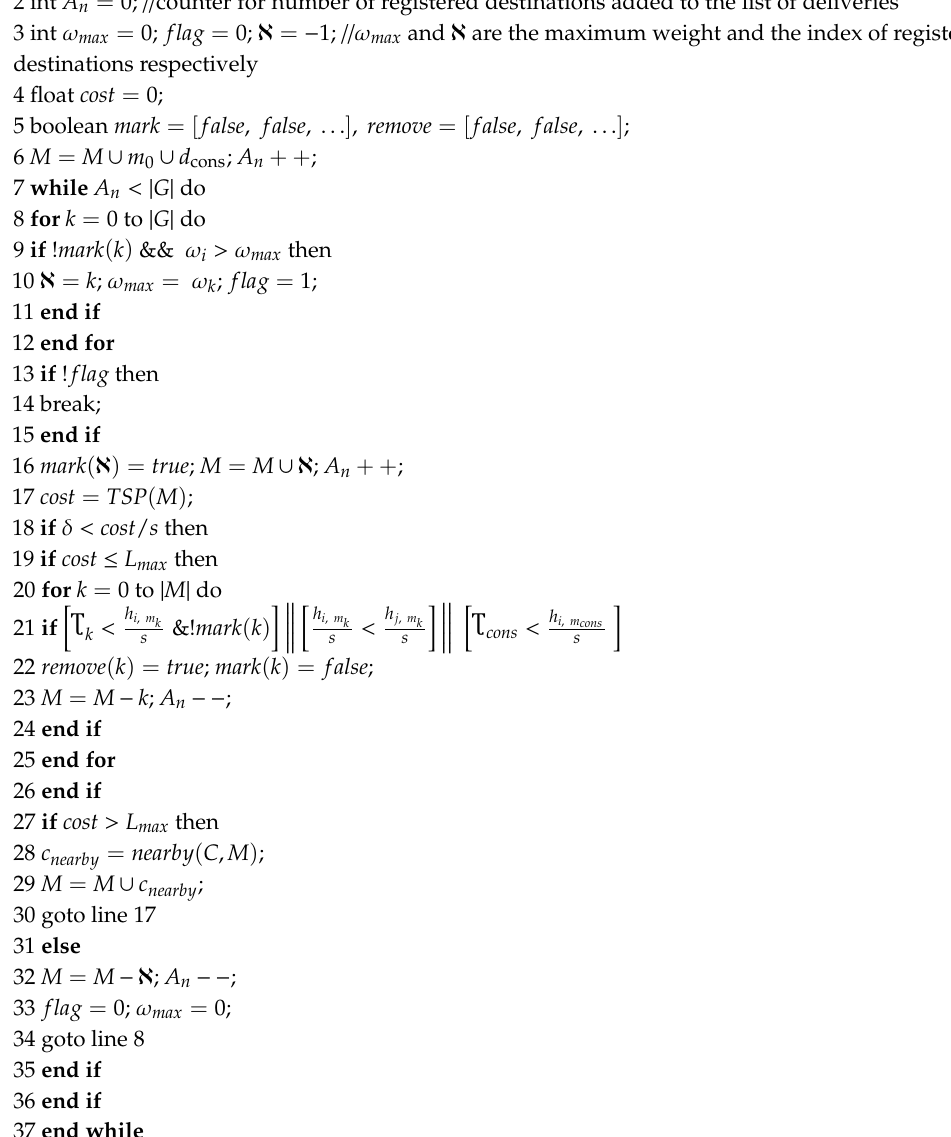
Table 1. Summary of notations.